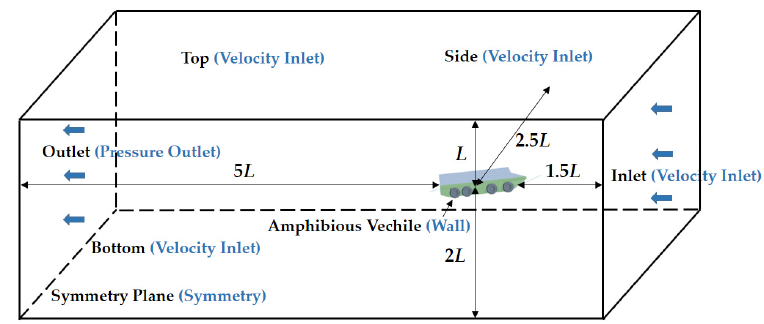
Figure 3. Flow field domain and its boundary conditions.